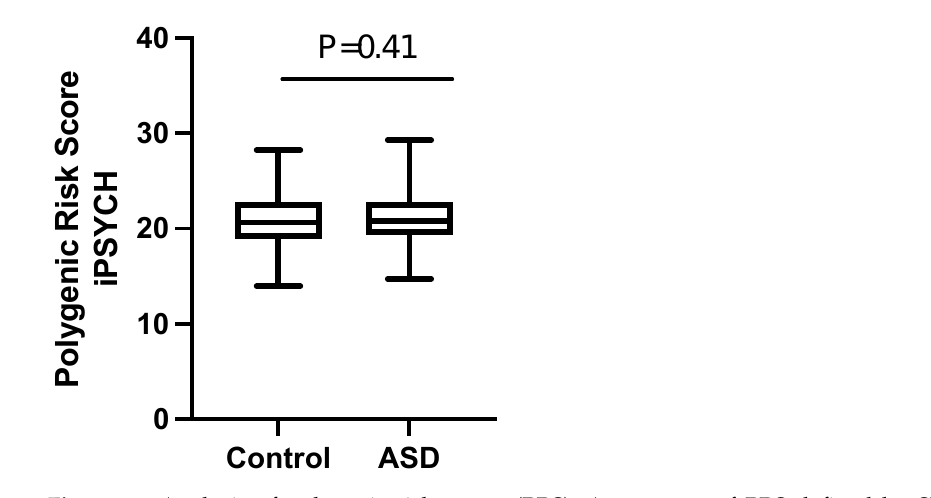
Figure 3. Analysis of polygenic risk scores (PRS). Assessment of PRS defined by SNPs with p < 1 × 10 −6 reported by Grove el al. (iPSYCH) [23] in our cohort. Values are presented as box and whisk- ers plots showing the interquartile range (boxes), median (horizontal line), the minimum and max- imum values (whiskers).